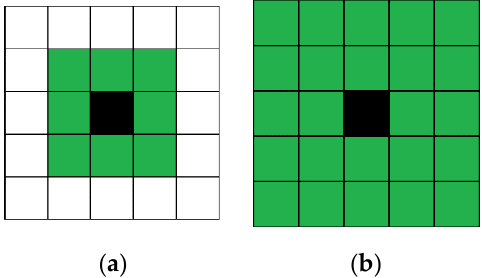
Figure 6. 1st ( a ) and 2nd ( b ) order Moore neighborhood. Green cells are neighbor cells for black cell.